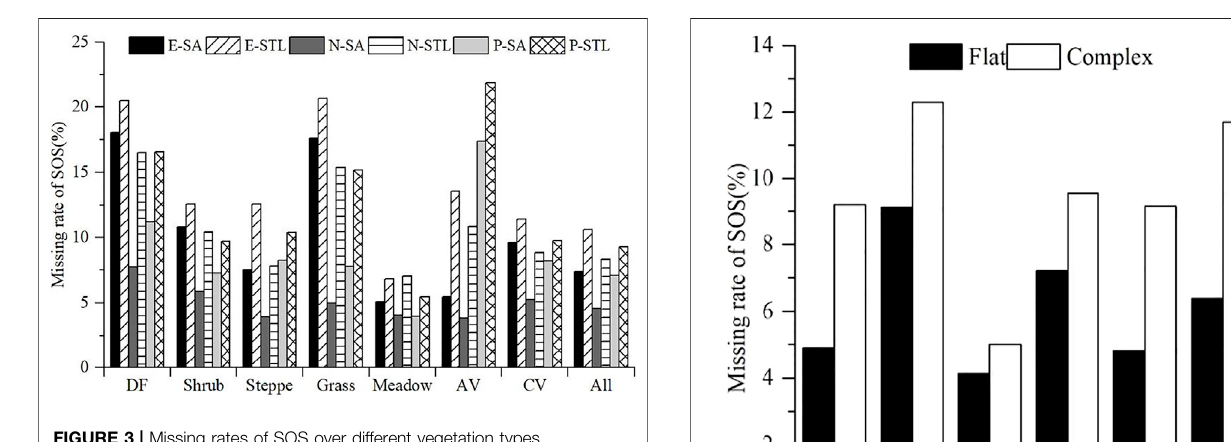
FIGURE 3 | Missing rates of SOS over different vegetation types.